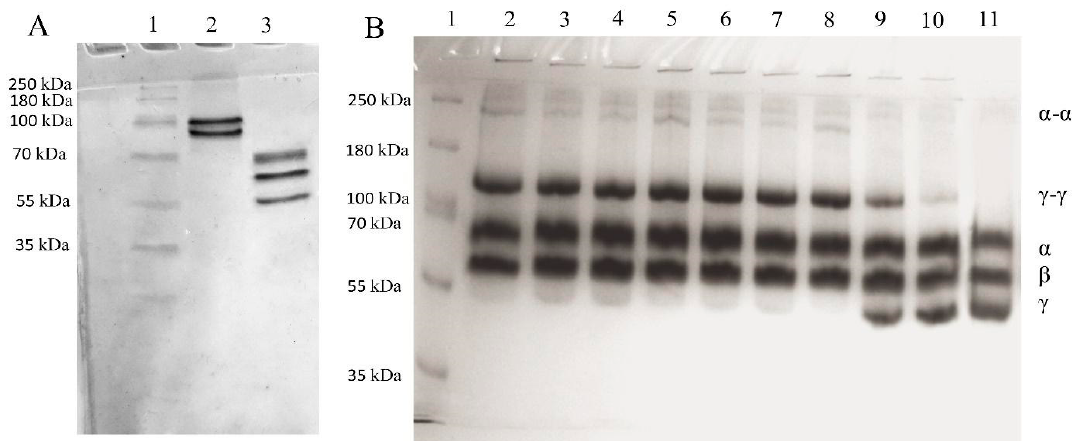
Figure 1. ( A ) Track 1—molecular weight markers: FXIII (track 2) and fibrinogen (track 3) isolated from plasma. The chains were separated by reducing 12% SDS-PAGE; ( B ) electrophoretic patterns of cross-linked fibrin chains in the presence of the di ff erent samples of FXIIIa: track 1—molecular weight standards; tracks 2–4—fibrin chains cross-linked by FXIIIa obtained from native proenzyme (FXIII), 50 µ M oxFXIII and 150 µ M oxFXIII; tracks 5–7—fibrin chains cross-linked by FXIIIa obtained from FXIII + Ca 2 + , 50 µ M oxFXIII + Ca 2 + and 150 µ M oxFXIII + Ca 2 + ; tracks 8–10—fibrin chains cross-linked by FXIIIa obtained from untreated FXIII + Ca 2 + / Thr; 50 µ M oxFXIII + Ca 2 + / Thr